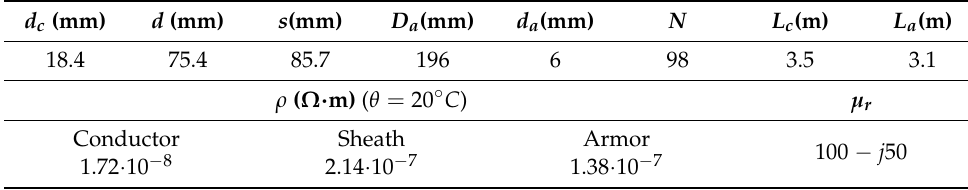
Table 1. Main parameters of a 115 kV, 240 mm 2 TCAC.